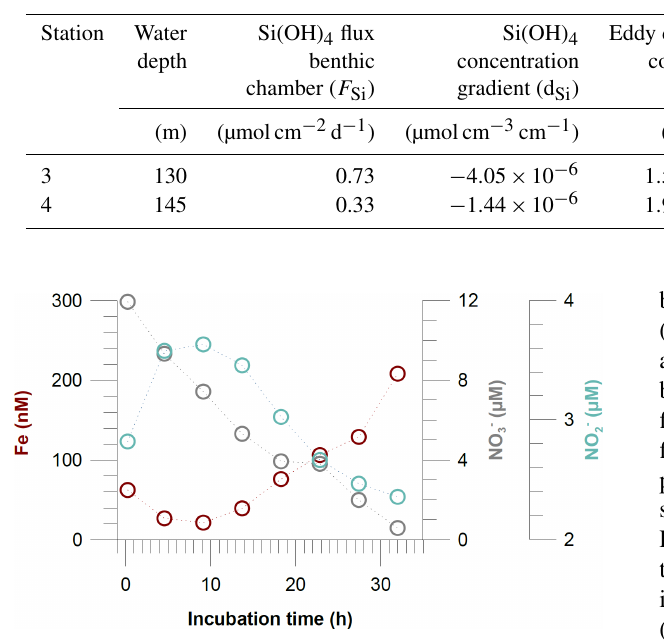
Figure 8. Dissolved Fe, nitrate (NO − trations in incubated bottom waters from the benthic chamber incu- bation at Station 4 (145m water